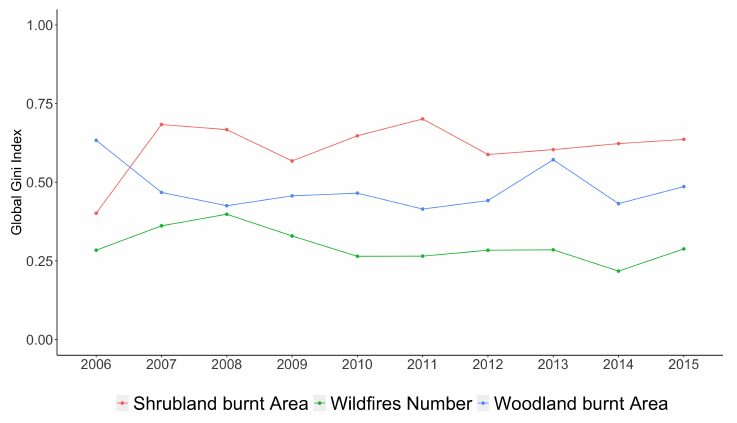
Figure 4. Global spatial Gini index analysis.